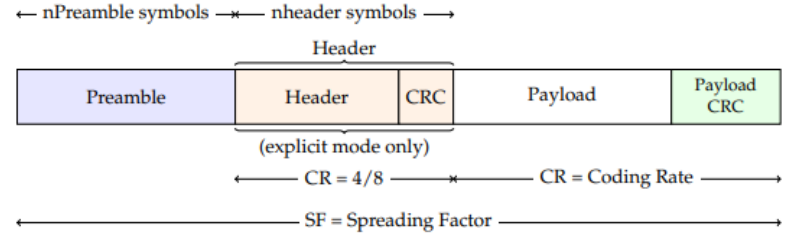
Figure 2. LoRa frame format (adapted from [14]).